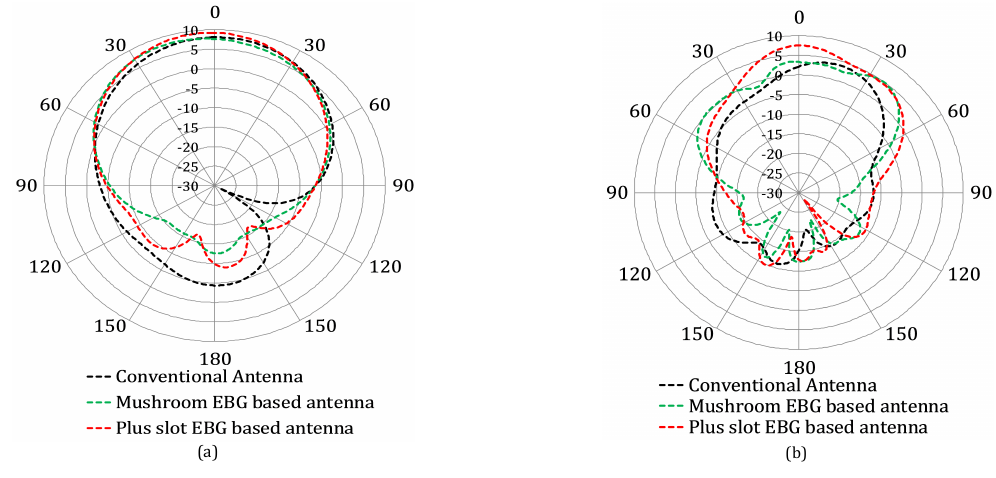
Figure 16. Gain patterns without and with EBG ground planes at ( a ) 2.5 GHz and ( b ) 5.2 GHz.